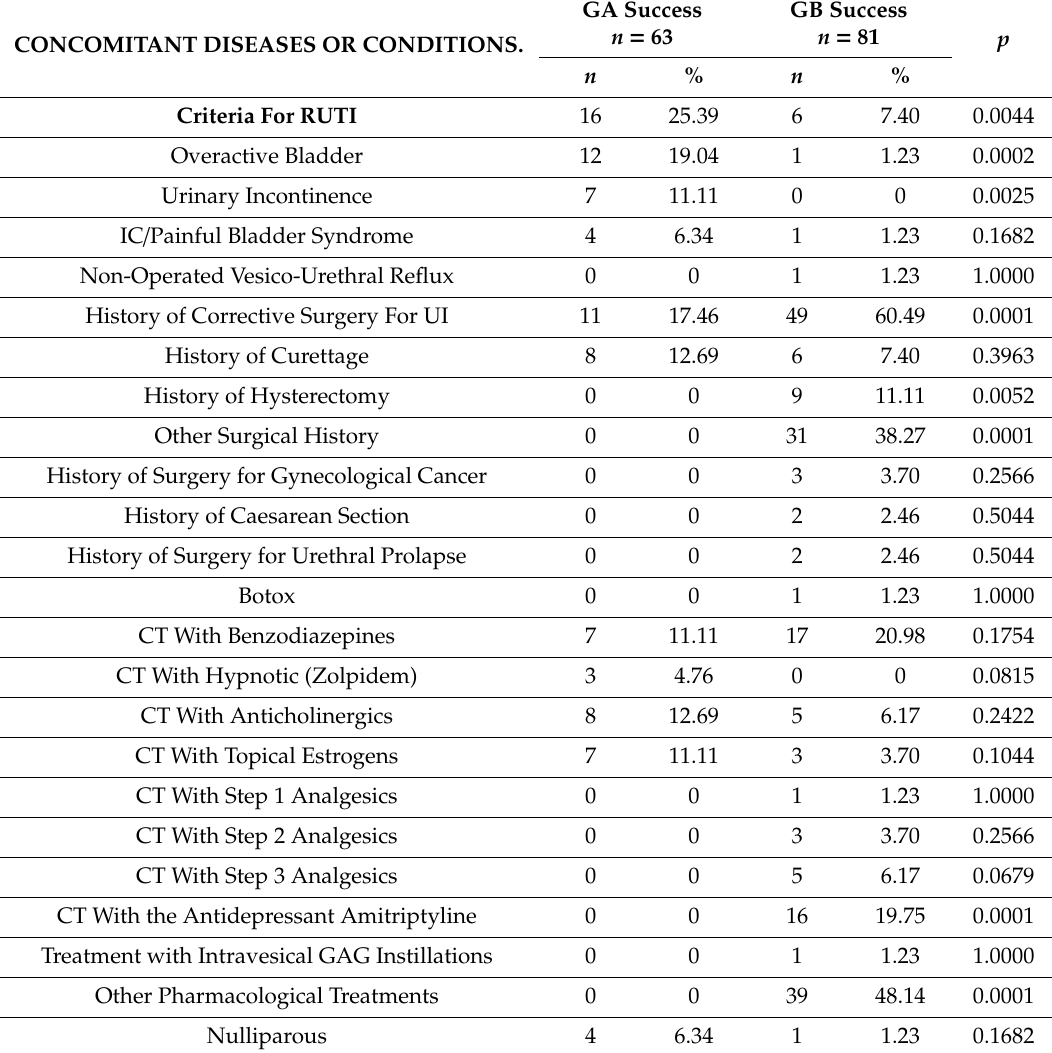
Table 3. Distribution of diseases and concomitant health conditions in GA and GB in which there was significant improvement in HRQoL SF-36